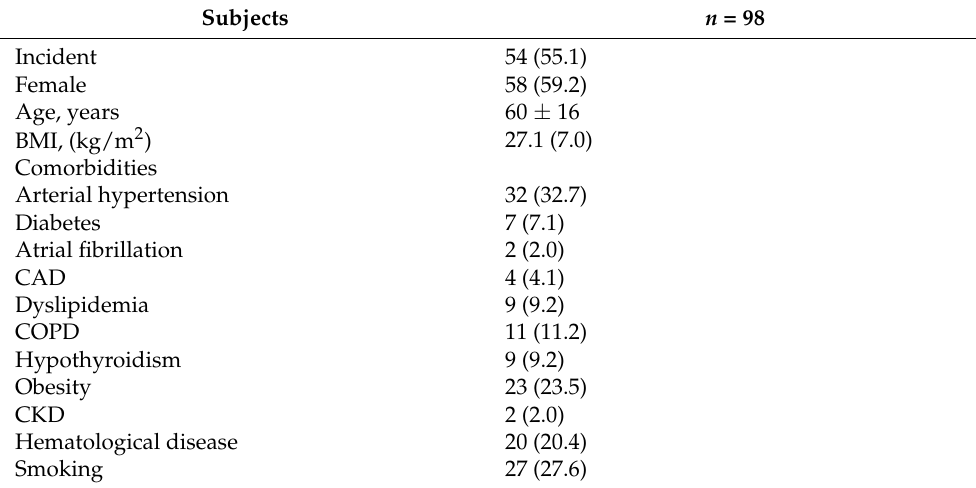
Table 1. Baseline demographic and clinical